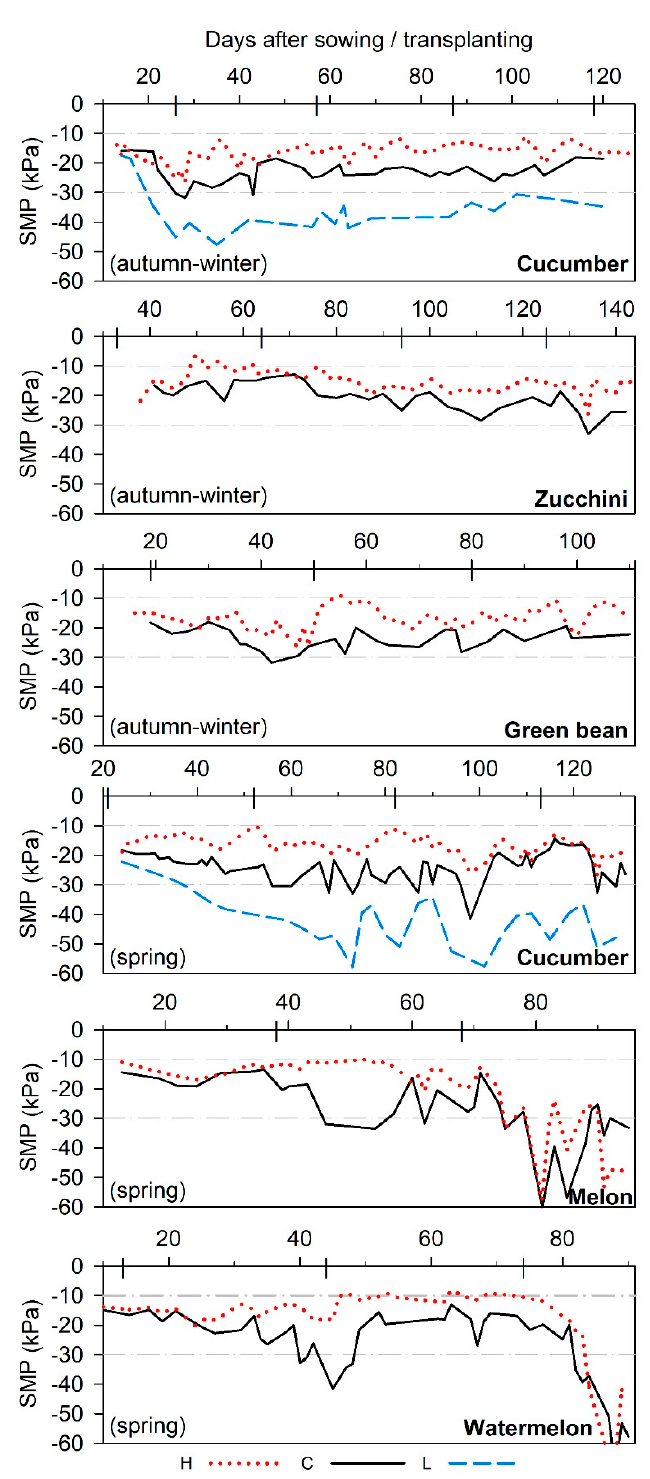
Figure 1. Seasonal evolution of the soil matric potential (SMP) measured before the irrigation in autumn–winter and spring cucumbers, autumn–winter zucchini and green bean, and spring melon and watermelon cycles of crops grown under high (H), conventional (C) and low (L) soil water availability. Mean values of measurements taken at 0.12 and 0.27 m below the gravel-sand layer and near the plant.